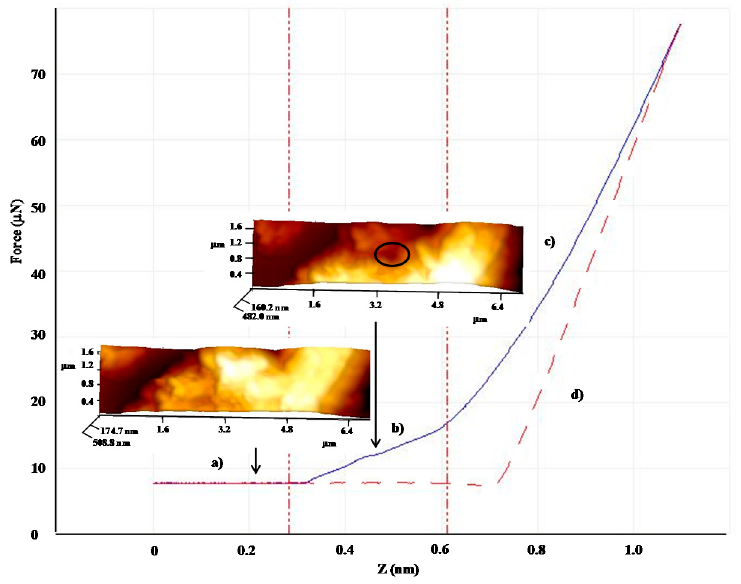
Figure 5. Mechanical testing of the elastic-plastic region by AFM of the MPCM composed by PS:tetracosane (1:3) microcapsule at 23 °C: ( a ) no contact, continuous line; ( b ) plastic penetration; ( c ) deformation of the sample; and ( d ) retraction of the AFM probe, discontinuous line.